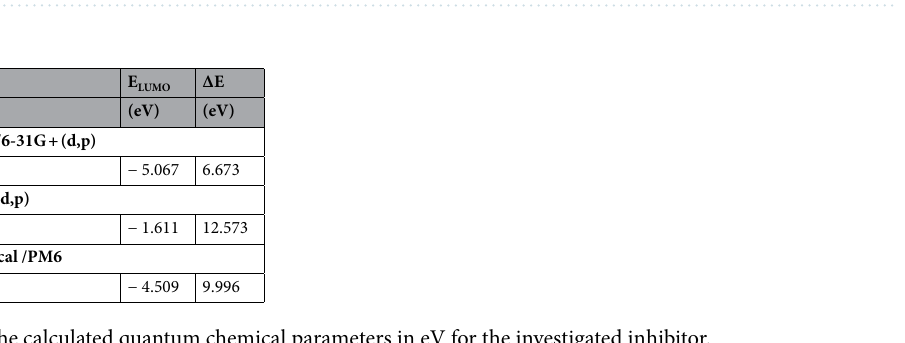
Table 6. The calculated quantum chemical parameters in eV for the investigated